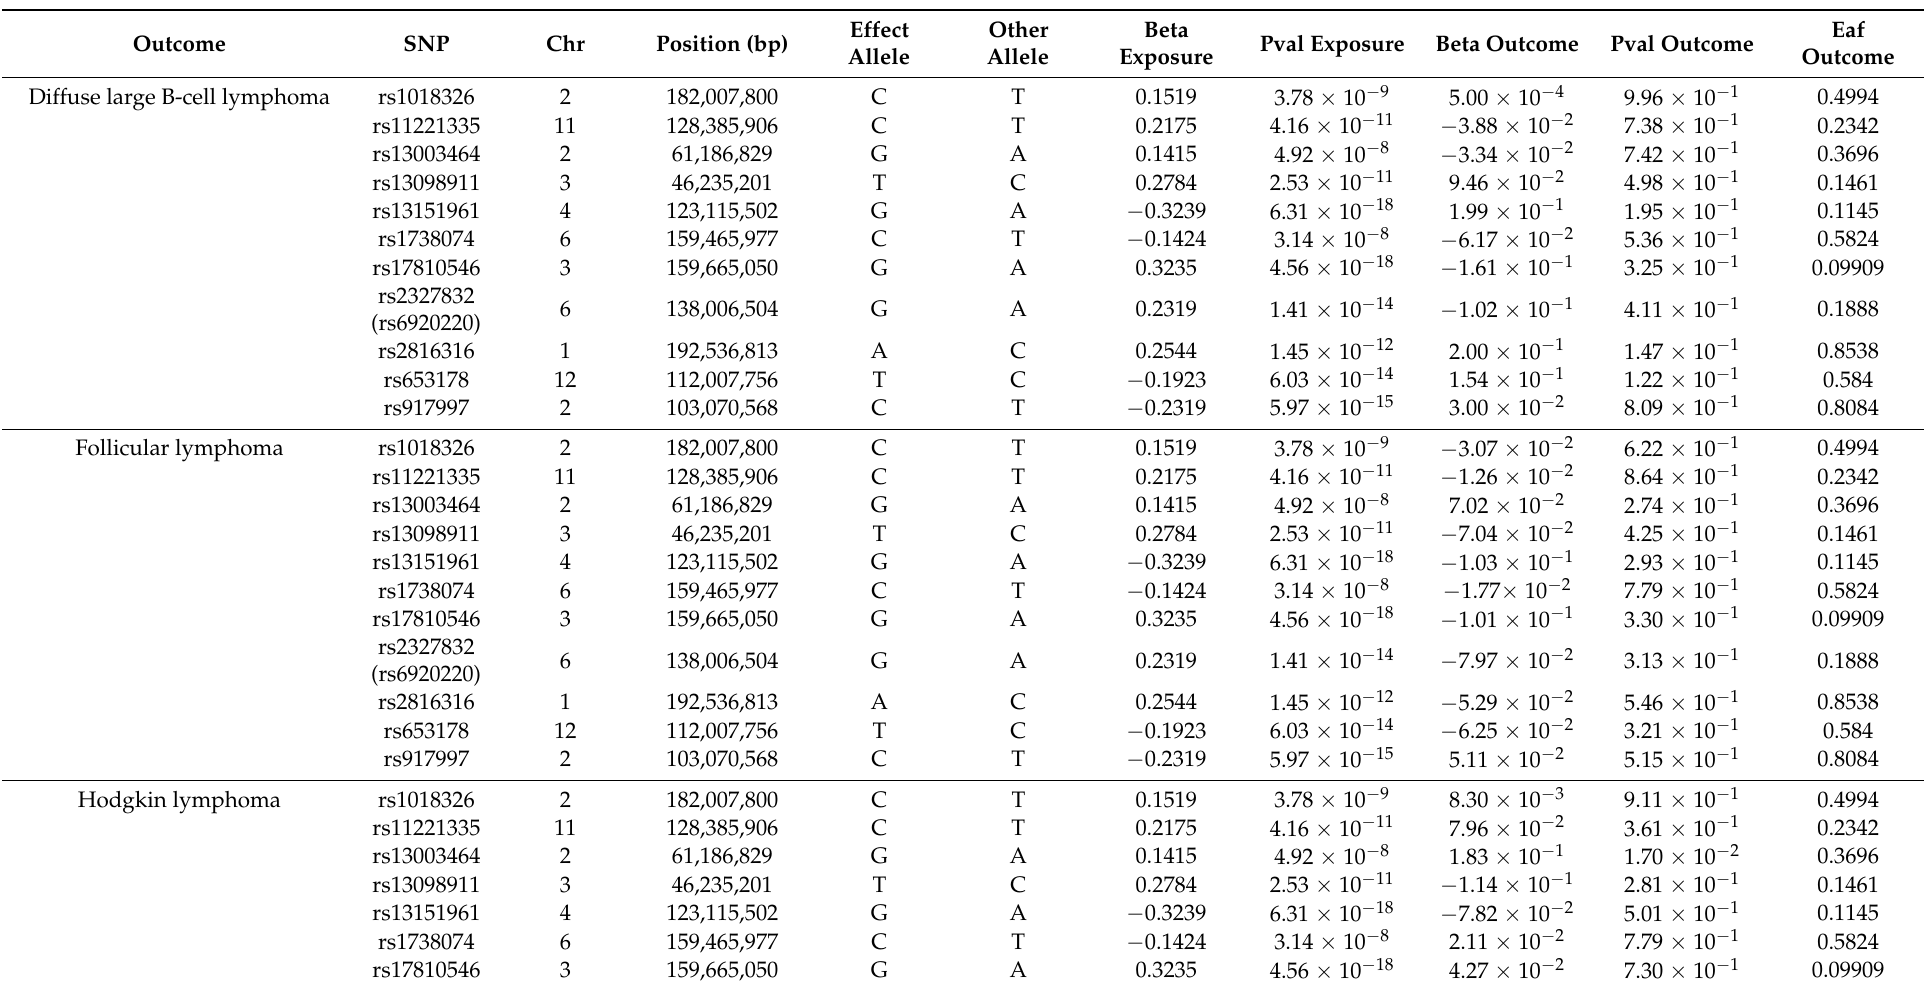
Table 1. IV genetic association results in the original GWAS datasets. Where celiac disease is the exposure and small bowel cancer or different lymphoma subtypes are the